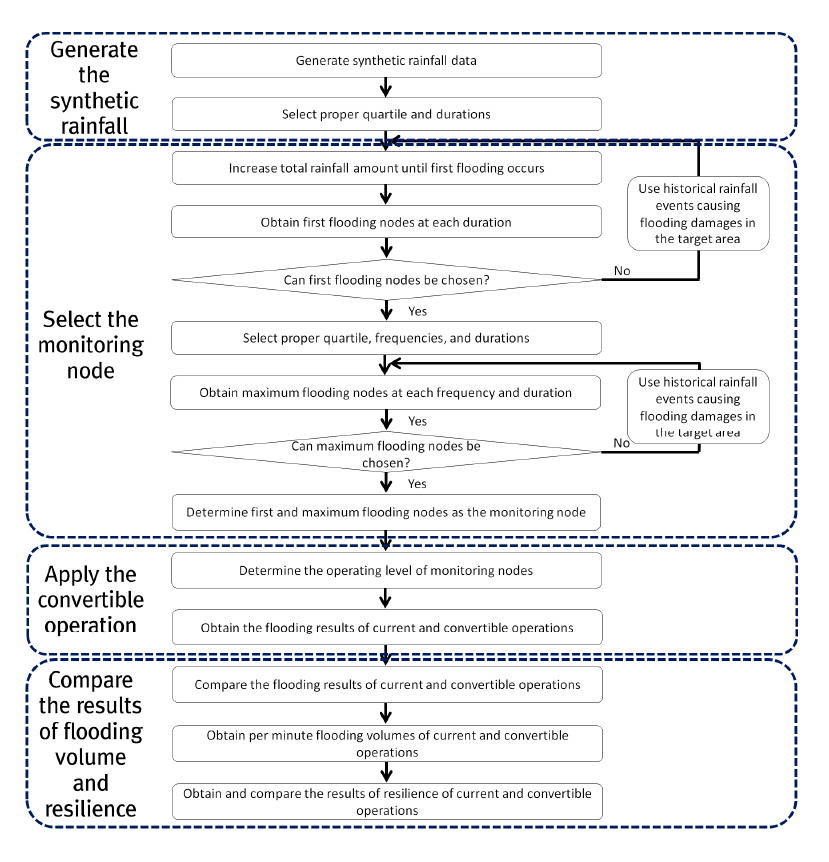
Figure 1. Flowchart of this study.